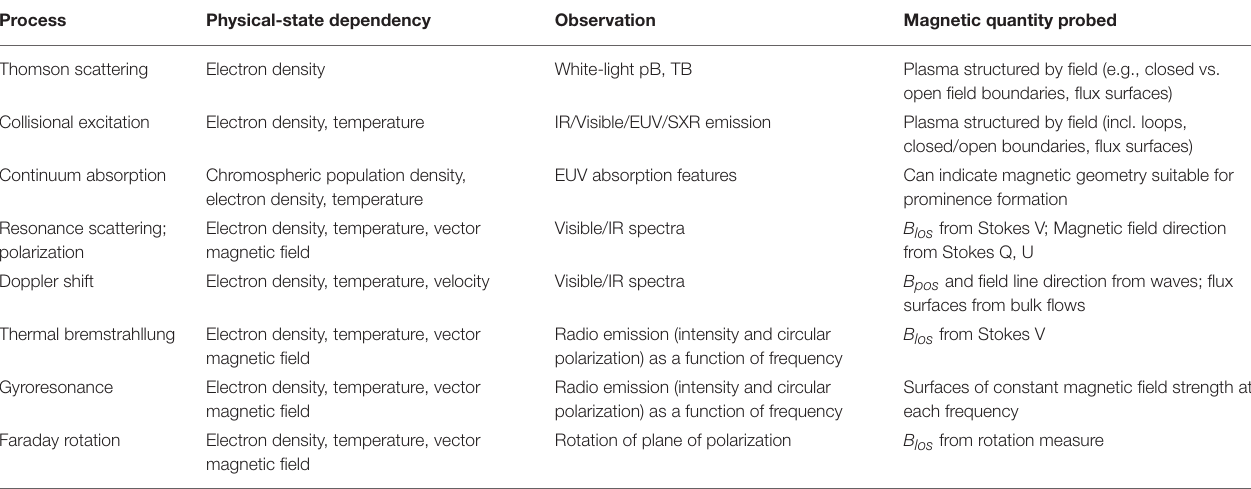
TABLE 1 | Physical processes as defined in Section 3, highlighting dependency on attributes of the physical state, which observations are sensitive to them, and diagnostic sensitivity to the 3D coronal magnetic